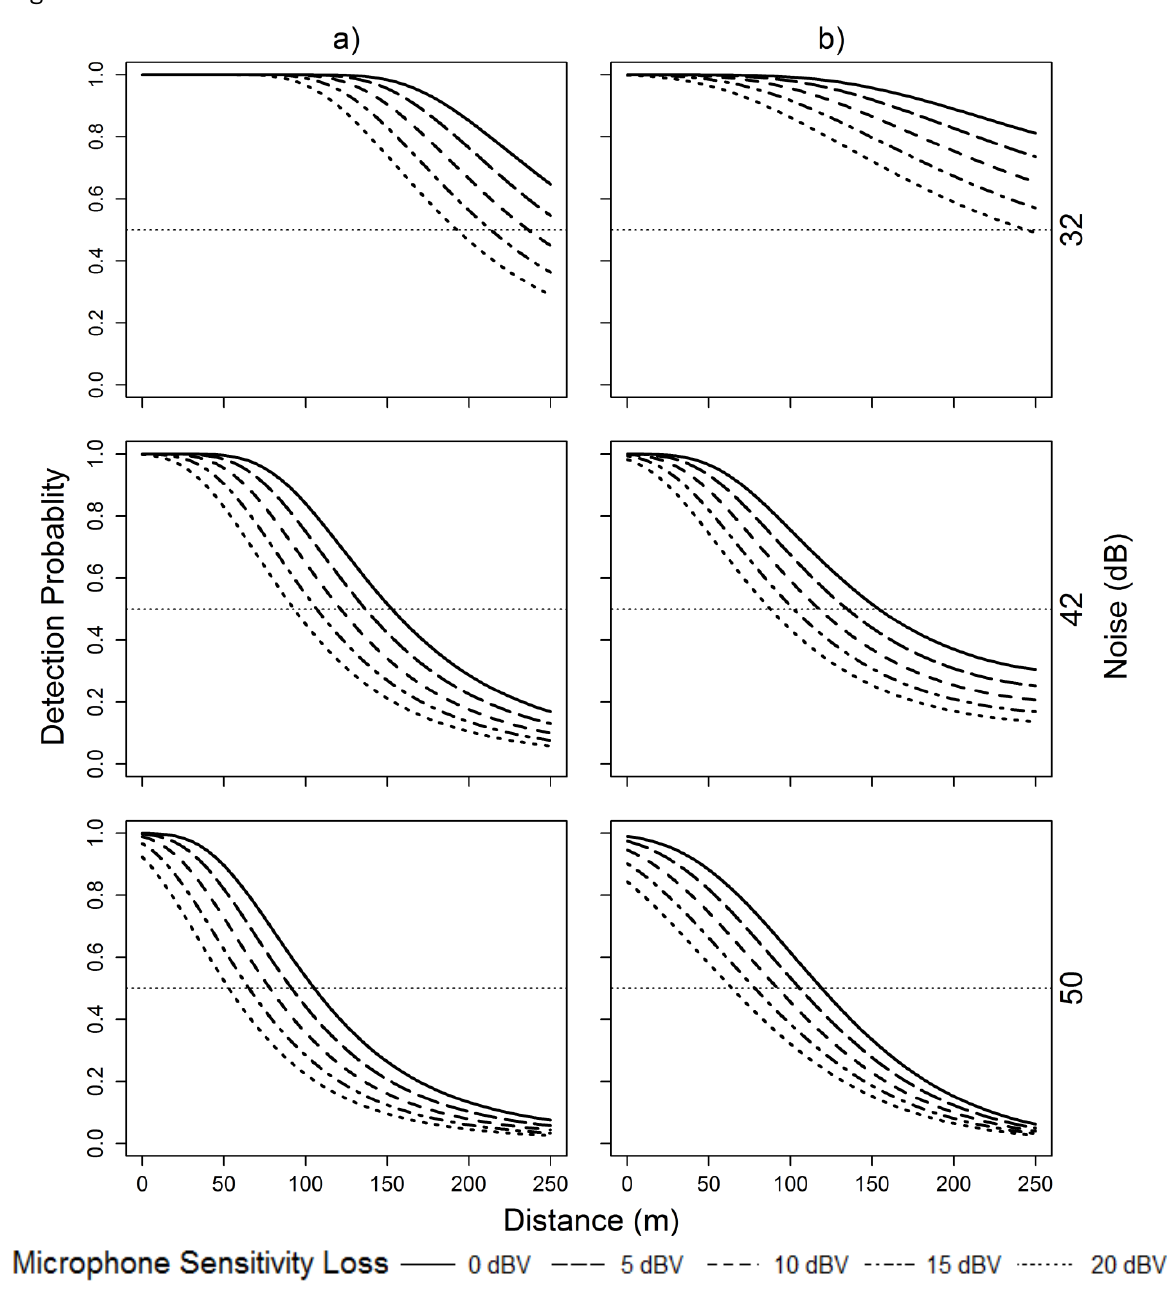
Figure A4.4. Detection probabilities of a) Sora per-weep calls and b) Sora whinny calls for five levels of microphone sensitivity loss and under three noise conditions based on selected binomial regression model. The dotted horizontal line indicates where detection is